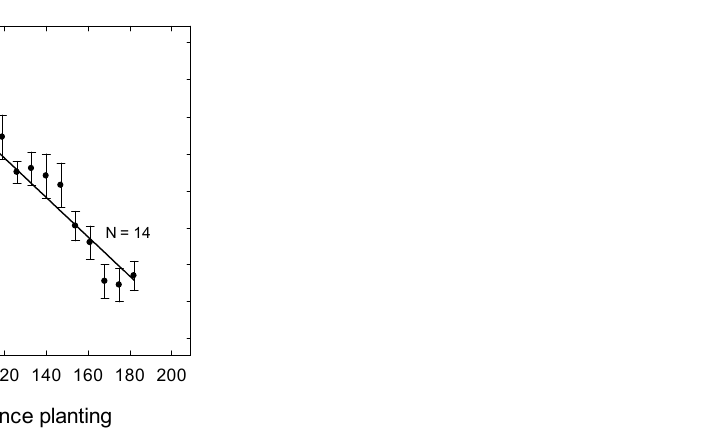
Average daily mean temperature ( o C) five to seven weeks before harvest